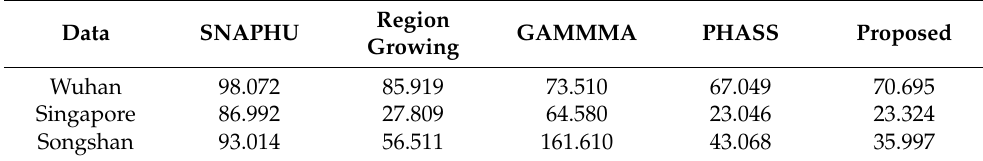
Table 3. Runtime (sec) cost of the five different PU